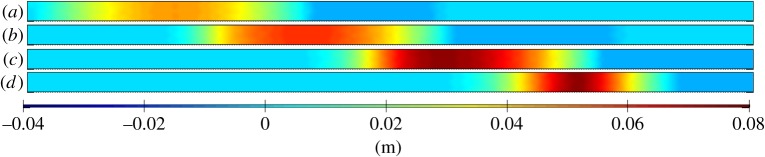
Snapshots of distribution of the water levels along a narrow, long channel. The channel is 400 km long and the snapshots are at 55 min intervals. Panels (a–d) represent water levels at 50 min intervals.